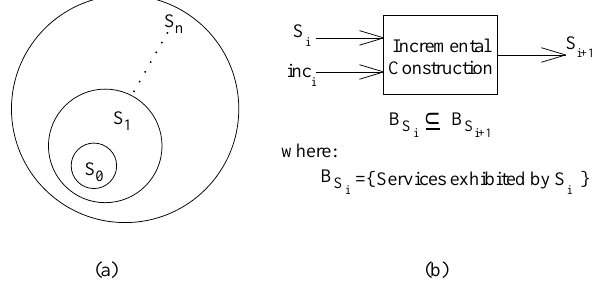
Figure 4. Incremental construction process.